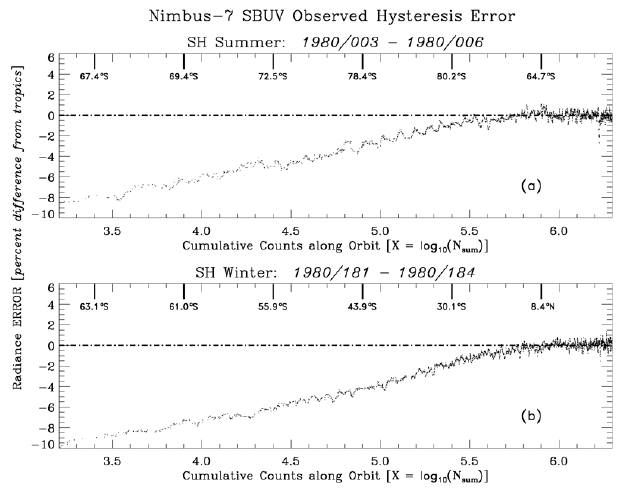
Fig. 13. Hysteresis error for Nimbus-7 SBUV reflectivity measure- ments, plotted as a function of accumulated counts. The dark tick marks in each panel show the approximate latitude corresponding to the indicated signal level. (a) Average values for 3–6 January 1980.